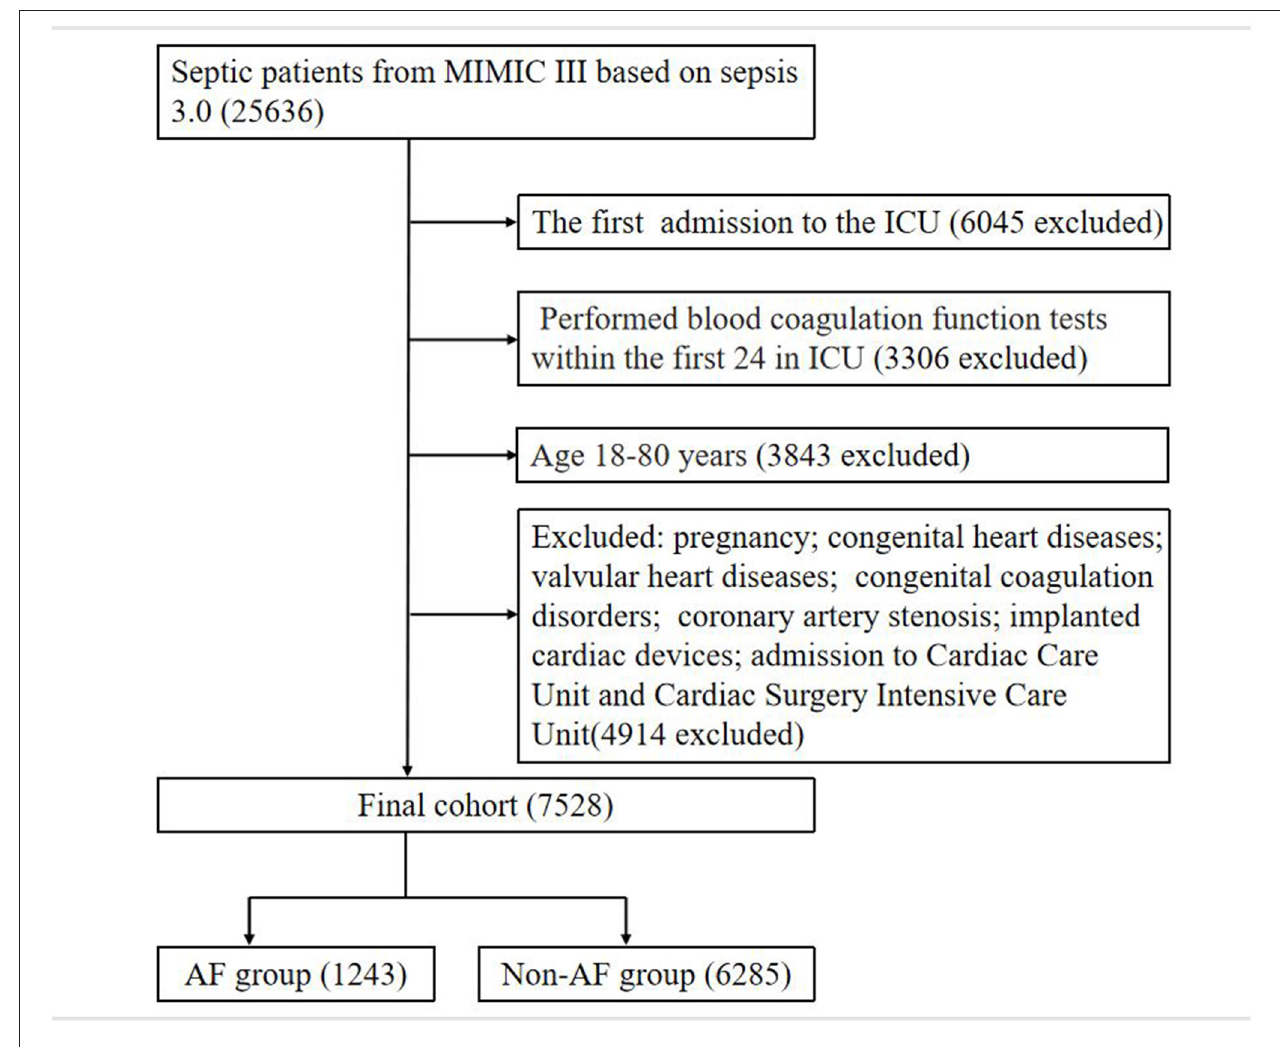
FIGURE 1 | The flowchart of study patients. early coagulation disorder and AF on mortality was assessed by multivariate logistic regression